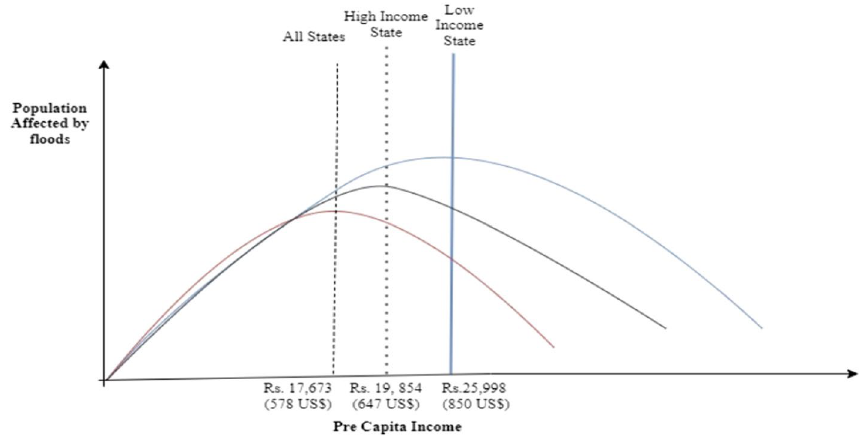
Figure 5. Turning point for population affected by floods with per capita income-all states, high income, and low-income